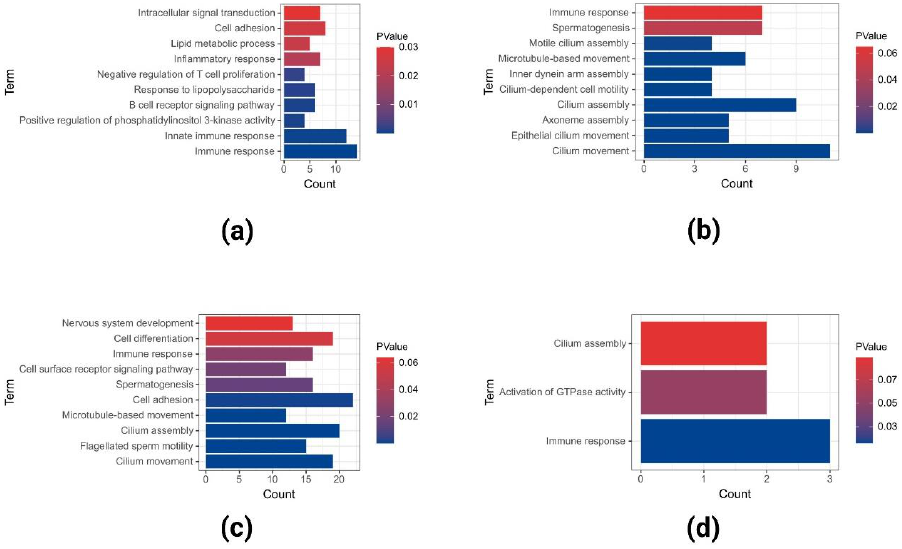
Figure 6. GO analyses of downregulated DEGs in GSE40290 ( a ), GSE61218 ( b ), GSE53819 ( c ), and co-downregulated DEGs ( d ) in the three datasets.